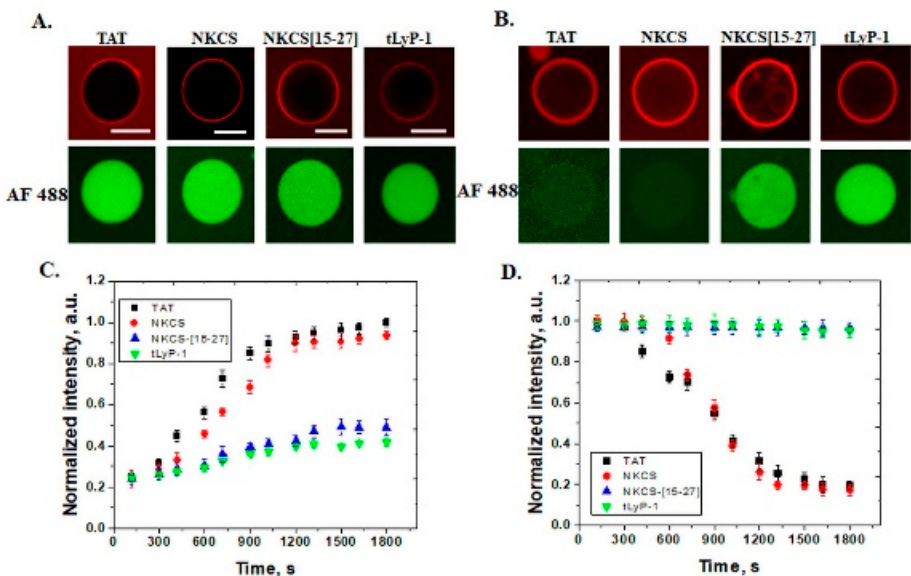
Figure 4. Internalization of peptides and efflux of Alexa Fluor 488 from POPS GUVs. Interaction of peptides (TAT, NKCS, NKCS ‐ [15 ‐ 27] and tLyP ‐ 1) with GUVs containing POPC/POPS/chol 50/30/20 mol% and release of AF 488 in the lower panel, ( A ) after 5 min and ( B ) after 30 min. ( C ) The time dependence of the normalized fluorescence intensity measured inside GUVs for internalization of the four peptides (TAT ( ■ ), NKCS ( ● ), NKCS ‐ [15 ‐ 27] ( ▲ ) and tLyP ‐ 1 ( ▼ )) and ( D ) efflux of AF 488 tracer. Error bars indicate the standard deviation. Scale bars correspond to 20 μ m.